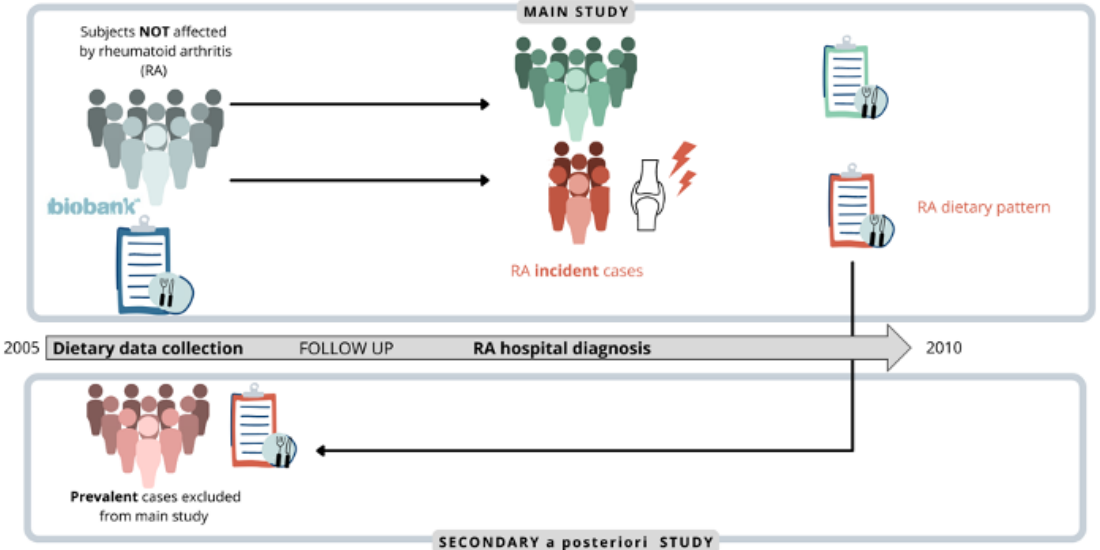
Figure 1. The analysis was aimed at finding an association between certain food items and the risk of rheumatoid arthritis (RA) onset and was conducted considering only RA new diagnosis (incident cases, shown in bold) as outcomes. The observed associations were further explored comparing the distribution of food frequency levels in incident and prevalent cases (people already affected by RA at enrollment, shown in bold).